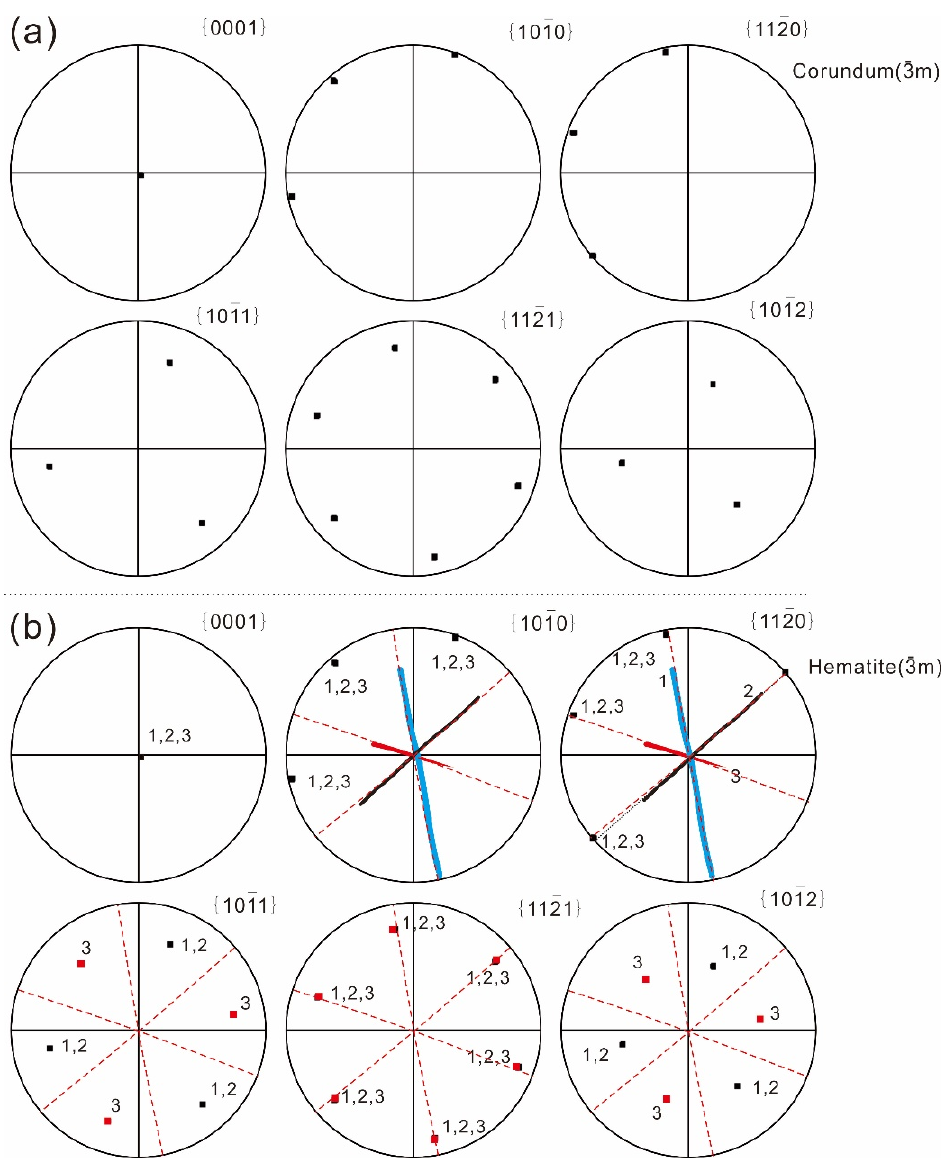
Figure 5. Pole figures of the corundum host and its hematite exsolutions. Upper hemisphere stereographic projections. ( a ) Pole figures of the corundum host. ( b ) Pole figures of hematite exsolutions. The pole points of hematite exsolutions are marked as 1, 2, 3 groups to distinguish the groups in three directions. The outline of actual hematite exsolutions is traced in ( b ) {1010} and {1120}. To legibly see the relationships of the selected exsolutions, the outline of six actual hematite exsolutions in Figure 4a–e are drawn and merged into Figure 6. The hematite exsolutions can be subdivided into three groups, each group of the exsolutions are approxi- mately parallel to each side of the equilateral